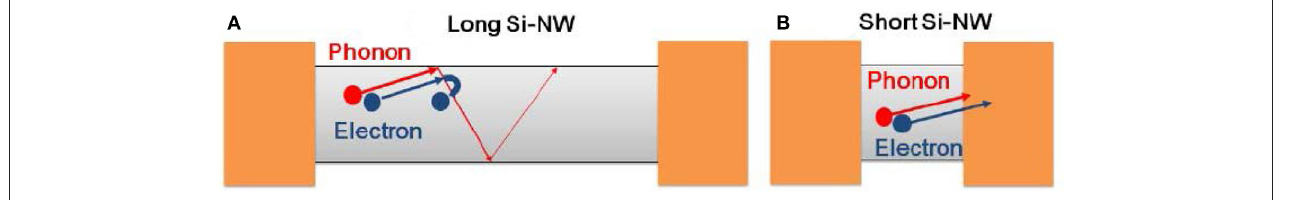
FIGURE 6 | Schematic of the thermal carrier behavior in the (A) long Si-NWs and (B) short Si-NWs. Reprint with permission from Tomita et al. (2018a).